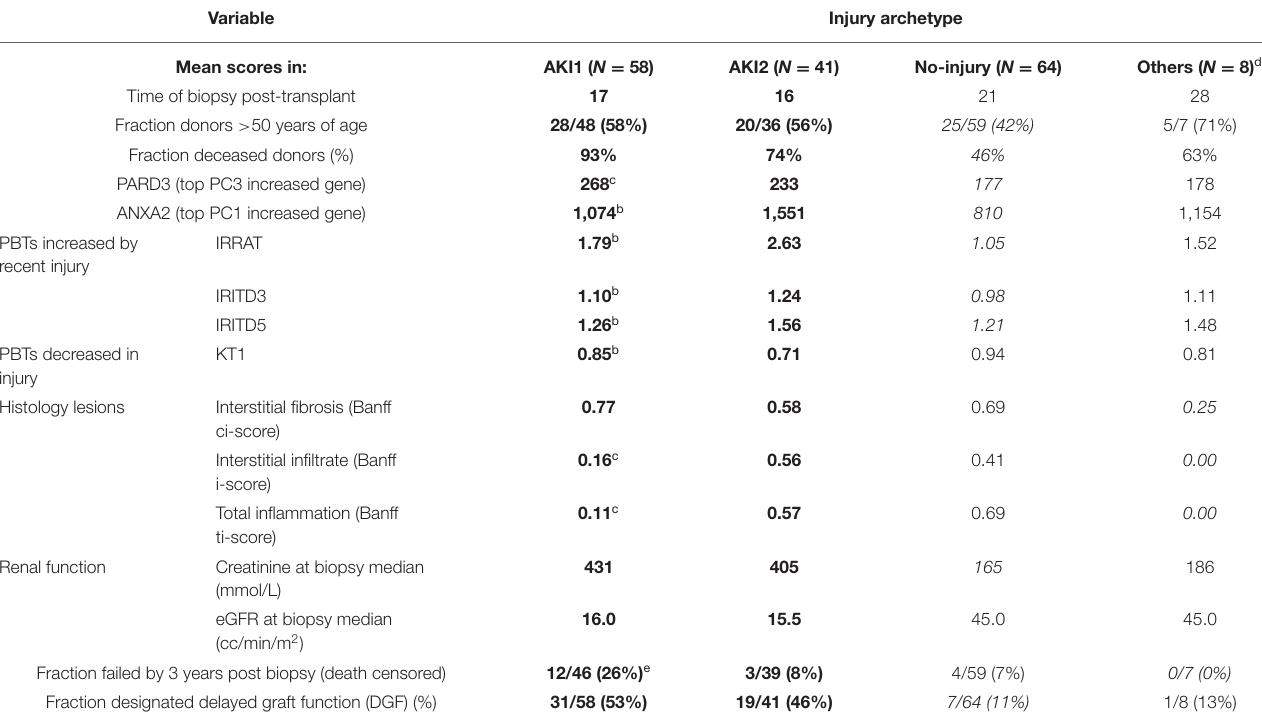
TABLE 5 | Distinct phenotype in early biopsies ( ≤ 6 weeks post-transplant) with no molecular rejection a ( N = 171).